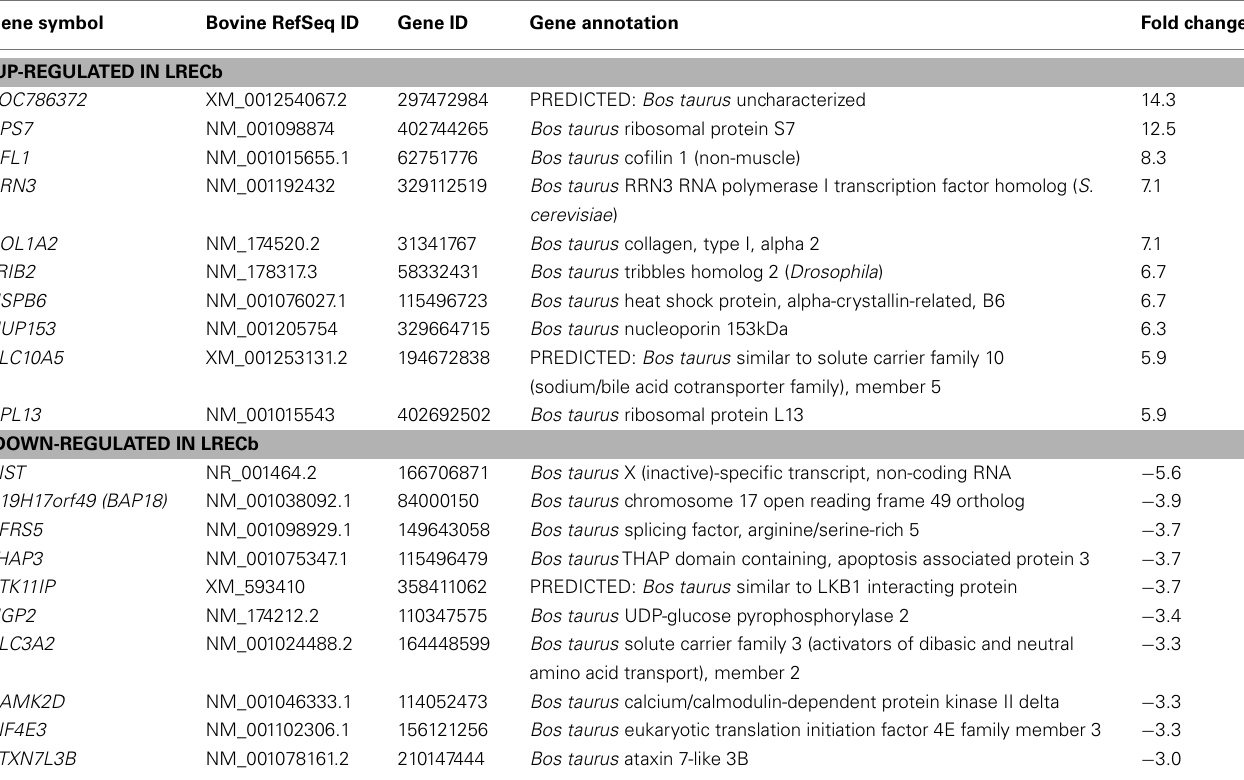
Table 3 |Top 10 up-regulated and down-regulated genes in LRECb vs. LRECe. Gene